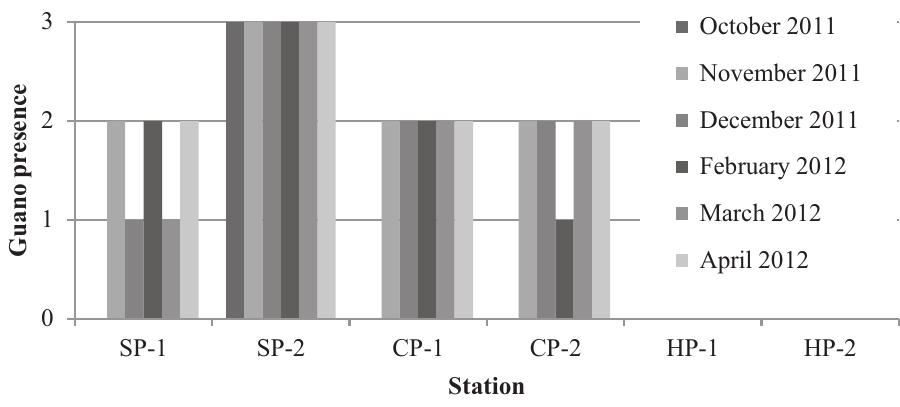
Figure 7. Presence of guano on researched habitats (0 – absent, 1 – low quantity, 2 – medium quantity, 3 – high